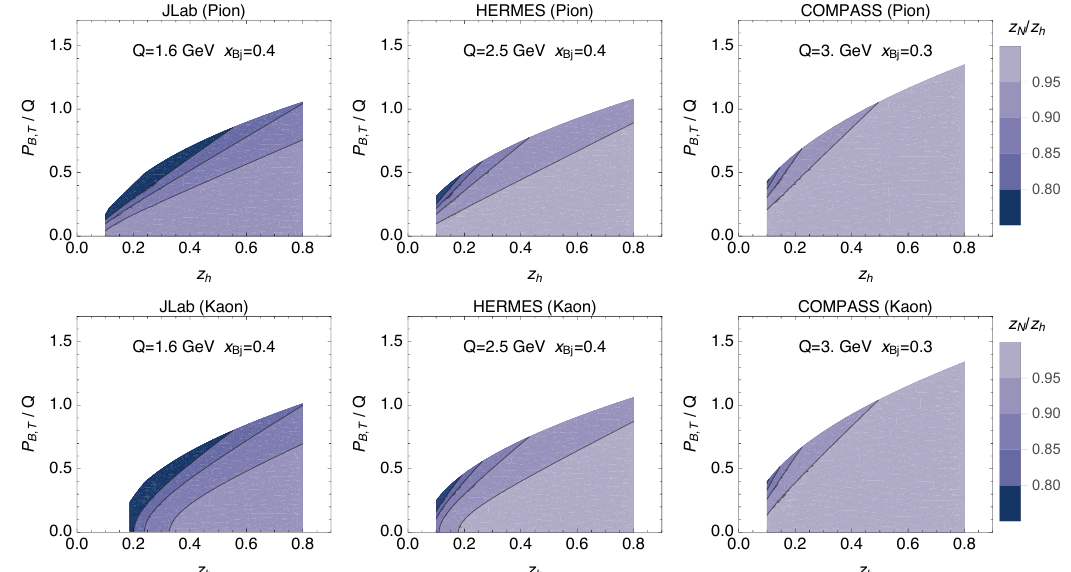
Figure 4 . The ratio z N =z h , eq. (2.24), is represented over the kinematic coverage in ( z h ; P B;T =Q ) for JLab 12 (left panels), HERMES (central panels) and COMPASS (right panels), at some (cid:12)xed values of x Bj and Q , as indicated in the plot title. Appropriate experimental cuts, as reported in refs. [6, 27, 28], are applied in each case. The values of z N =z h , for pion production (upper panels) and kaon production (lower panels) are obtained using eq. (2.24) and are color-coded: the lightest shade corresponds to values very close to one, while darker shades correspond to regions where the ratio z N =z h increasingly deviates from 1 and the quality of the MHA deteriorates. Notice how deviations from 1 are more sizable as compared to those of x N =x Bj in (cid:12)gure 3, particularly in the JLab